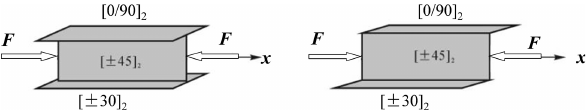
Figure 22: Laminate column structure subjected to axial